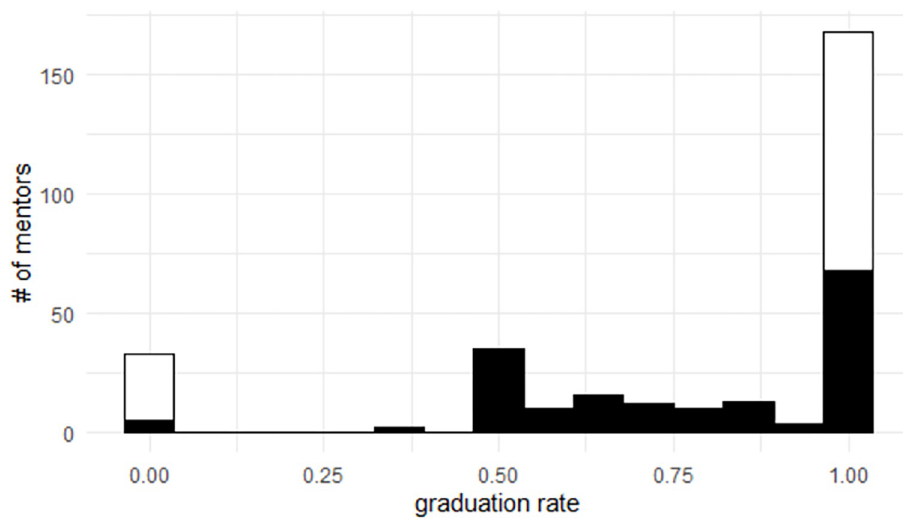
Fig 2. Distribution of graduation rate by